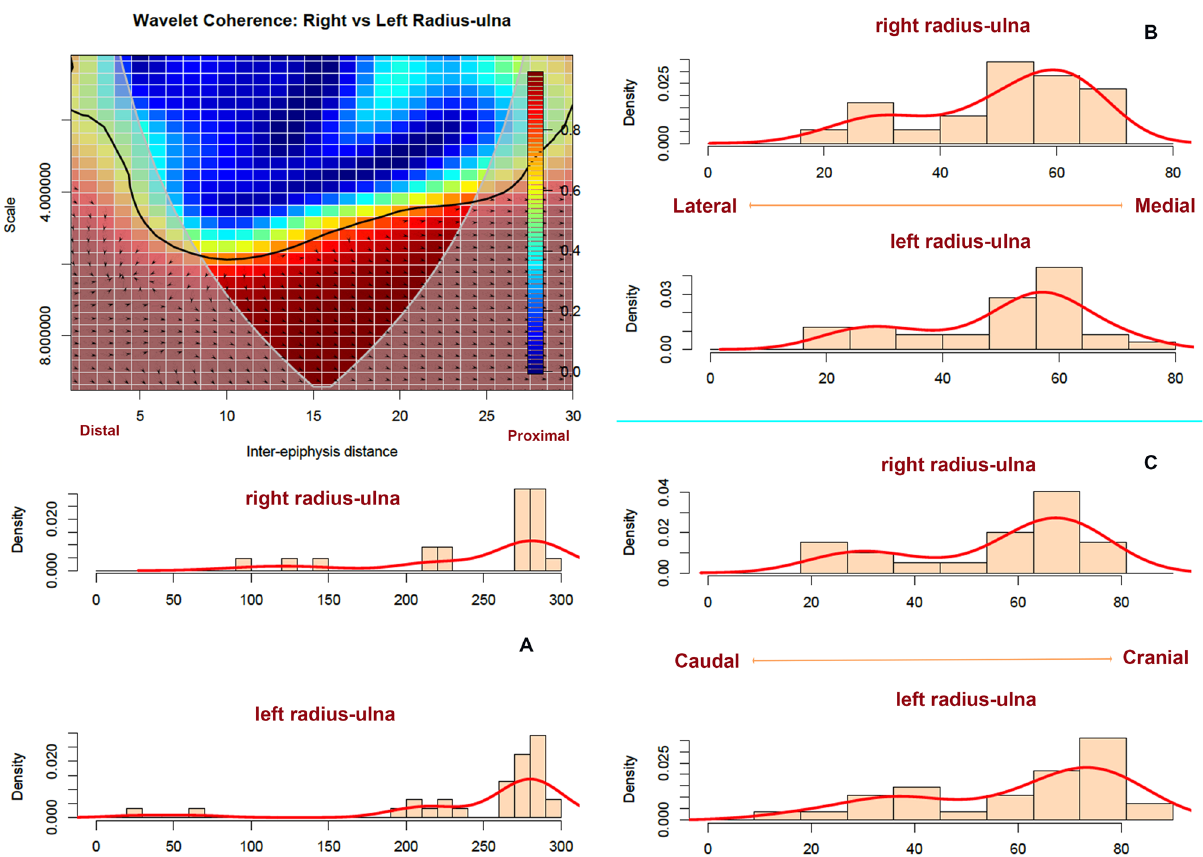
two high-correlation areas, both femoral sides are in phase (i.e., the covary together in the same direction). The right radius-ulna is leading (arrows pointing to the right-down or left-up). Binning of histograms is described in Table 3. ( A ) frequency of marks from distal end (left) to proximal (right) end; ( B ) frequency of marks from lateral (left) to medial (right), and, ( C ) frequency of marks on caudal(left) to cranial